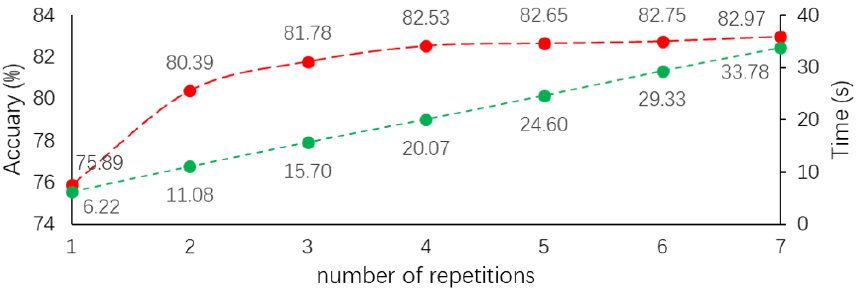
Figure 2. The red line shows the relationship between test accuracy and number of repetitions for 3/4 masked images from CIFAR-10, and the green line shows the amount of time (in seconds) that is required to test 10,000